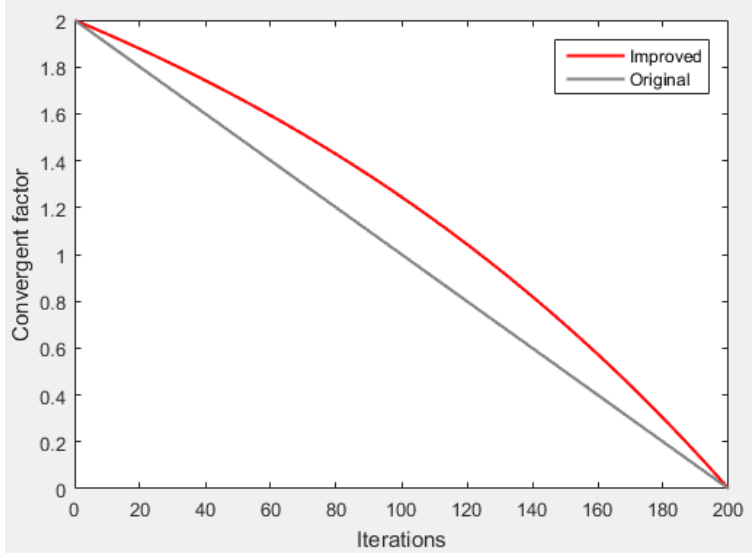
Figure 2. The convergence trend of a .